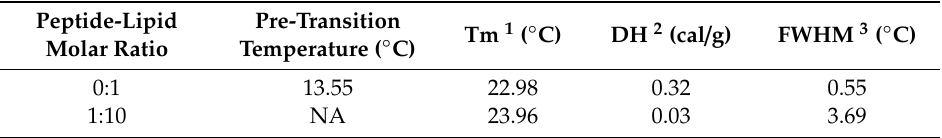
Figure 2. Thermograms of DMPC/DMPG (3:1) multilamellar vesicles (MLVs) in the absence (green line) and presence of the peptide (blue line) at a peptide–lipid molar ratio 1:10. Table 4. Tm, DH and FWHM values before and after adding the peptide to MLVs constituted by DMPC / DMPG